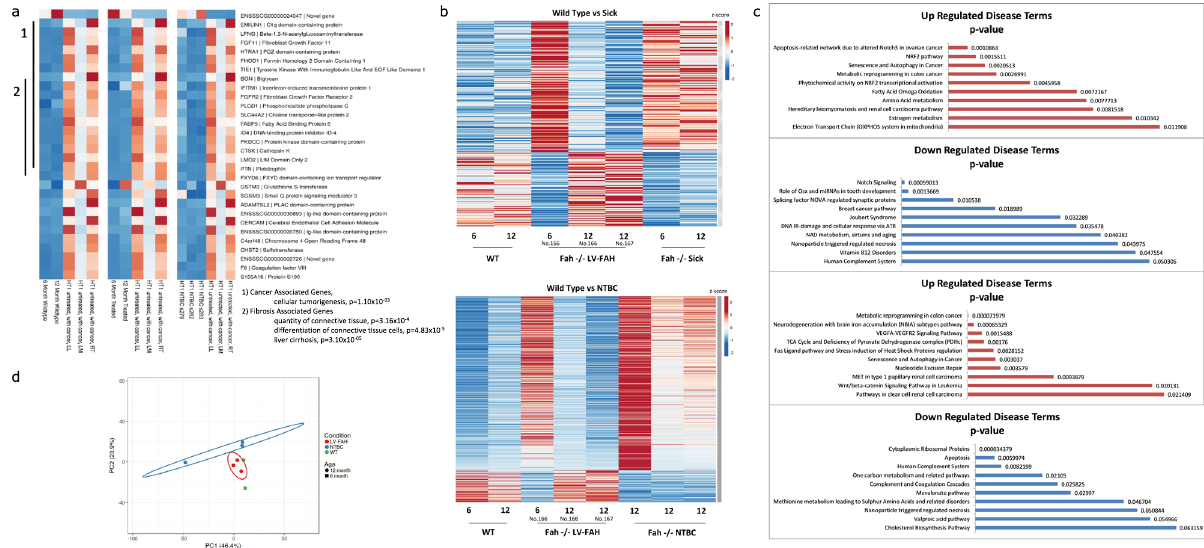
Fig. 5 | RNA expression analysis shows LV-FAH restores wild type expression pro fi lesbetterthanstandardNTBCtreatment.a Individualheatmapscomparing RNA expression levels of the genes listed on the right between wild-type pigs at 6 and12monthsofage(left),LV-FAH-treatedpigsat6and12monthsofage(middle) andNTBC-treatedpigsat12monthsofage(right).Genesdisplayedaretheresultof overlapping differential expression analyses across the three comparisons with absolute log2 fold change>2 and FDR<0.05. Clusters are identi fi ed for 1. cancer- and 2. fi brosis-associated genes. b Individual heatmaps showing RNA expression level pro fi les comparing 6 and 12-month wildtype and LV-FAH-treated pigs with either FAH − / − NTBC-undertreated pigs (Sick, top) or NTBC-treated pigs (bottom). c Gene clusters represented in ( b ) organized by association with various disease and cancer pathways showing that over the course of 12months of LV-FAH